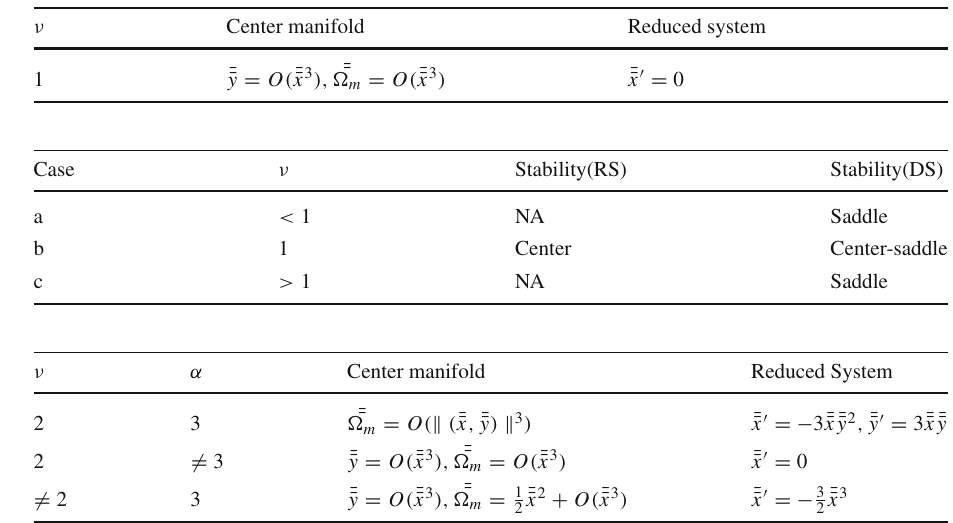
Center manifold Reduced